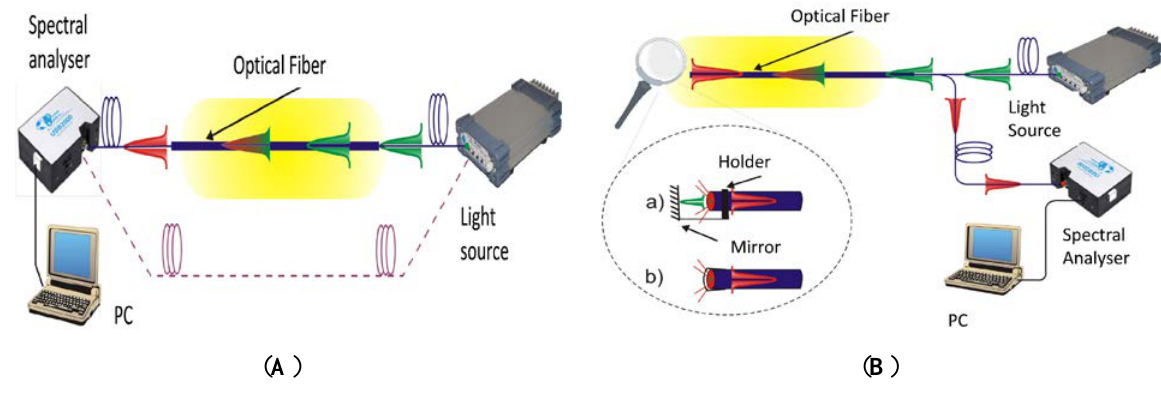
Figure 5. (A) Scheme of FOS in Reflection arrangement; ( B ) Scheme of FOS in Transmission arrangement. Reproduced from [47] with the permission of the CTU